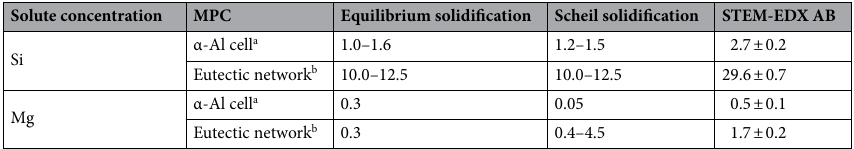
Table 6. Si and Mg solute concentrations in α-Al cell a and Al-Si eutectic network b based on numerical equilibrium and Scheil models (Thermo-Calc) and experimental chemical analysis of the AB microstructure by STEM-EDX. a Solute concentration (Si, Mg) from equilibrium and Scheil model are based on simulated solute concentrations in primary Al (FCC_L12). b Solute concentration (Si, Mg) from equilibrium and Scheil model are based on simulated solute concentration in the last fraction of the liquid phase.